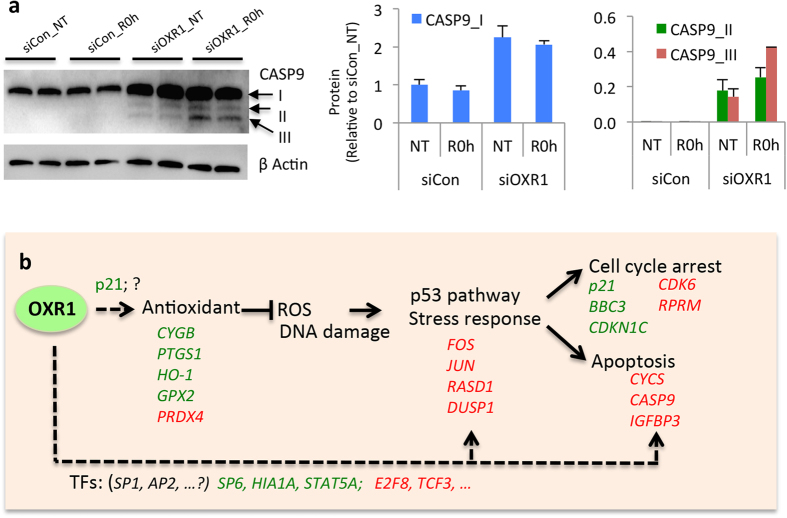
(a) Caspase 9 protein level increased and was partly cleaved into active forms in hOXR1 depleted HeLa. Left panel: Western blot analysis. Actin was used as internal loading control. Right panel: quantification of protein bands. siCon: control siRNA; siOXR1: hOXR1 siRNA; NT: non-treatment; R0h: cells were treated with 0.5 mM H2O2 for 1 h and harvested immediately without recovery. The quantification is the average of two independent experiments. (b) Model of hOXR1 mediated regulation of antioxidant defense, early stress response, cell cycle and apoptosis. HOXR1 up regulates transcription of four antioxidant genes, resulting in suppression of ROS and modulation of early stress response genes. In hOXR1 depleted cells, increased ROS leads to increased oxidative damage (i.e. DNA damage) that triggers cell cycle arrest in G2/M and apoptosis via regulation of RPRM, CASP9 and several other genes in the p53 pathway. We postulate that hOXR1 may regulate the early stress response, cell cycle and apoptosis directly or indirectly by interaction with transcription factors such as SP1 (Sp1 transcription factor) and AP2 (activating enhancer binding protein 2). Genes labeled in red or green are up- or down-regulated, respectively, in hOXR1 depleted cells.